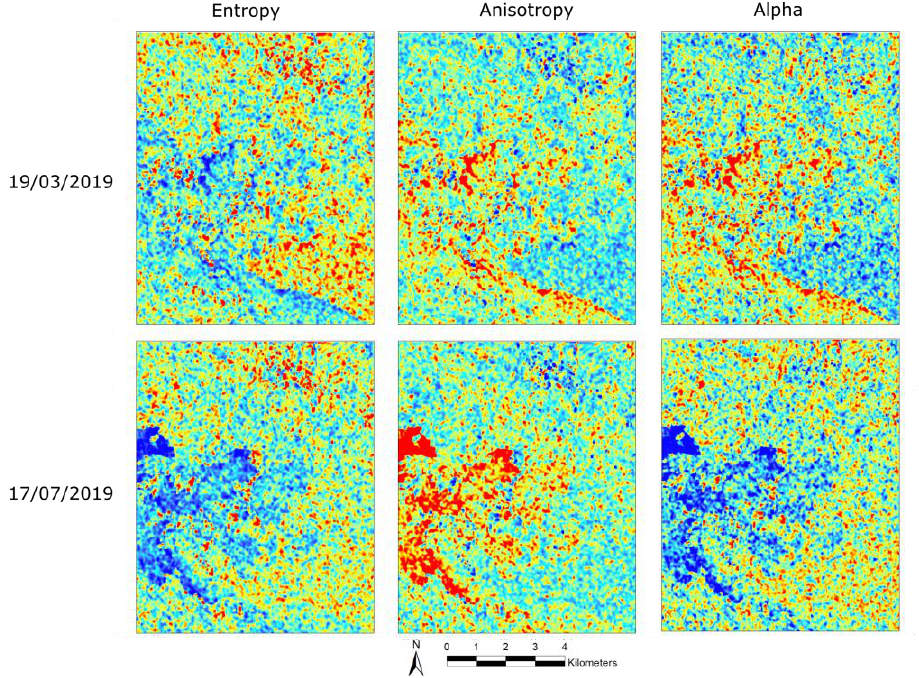
Figure 2. H/Alpha dual decomposition results